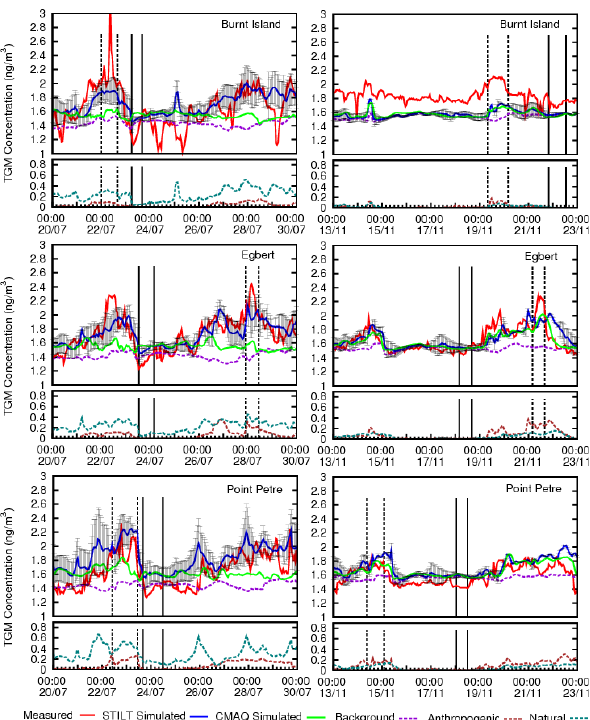
Fig. 4. Total gaseous mercury (TGM) concentration comparisons among observed (red), STILT modeled (blue), and CMAQ modeled (green) for two simulation periods: 20–29 July (left) and 13–22 November (right), 2002 for Burnt Island (top), Egbert (middle) and Point Petre (bottom). Background concentrations derived from the lateral boundary condition is in violet. The anthropogenic (brown) and natural (teal) contributions to the simulated concentration are shown as dashed curves in the lower panels. Black dashed lines in the vertical designate a selected high Hg episode; black solid lines designate a selected low Hg episode.